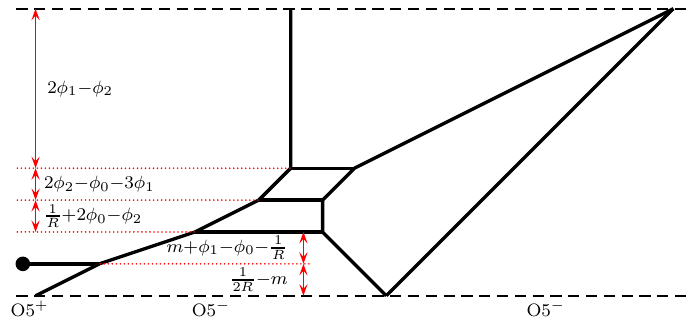
Figure 12. Lowering the flavor brane in figure 11 through a series of flop transitions, so as to apply the Higgsing procedure discussed in figure